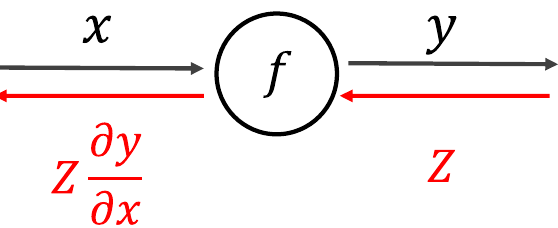
Figure 2. A Simple computational graph of forward and backward processes.